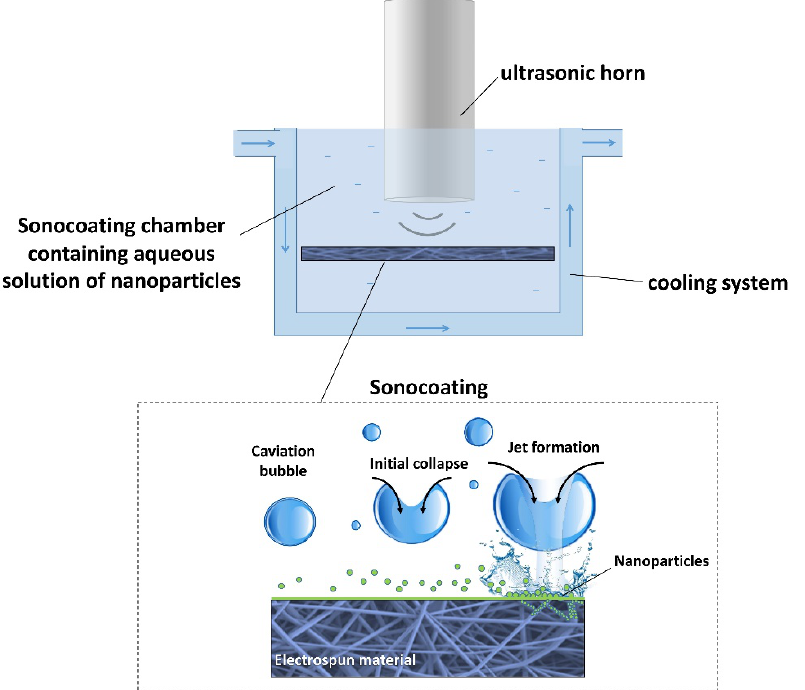
Figure 2. Schematic view of ultrasonic coating setup and ultrasonic cavitation phenomenon occurring near the membrane surface during the process.